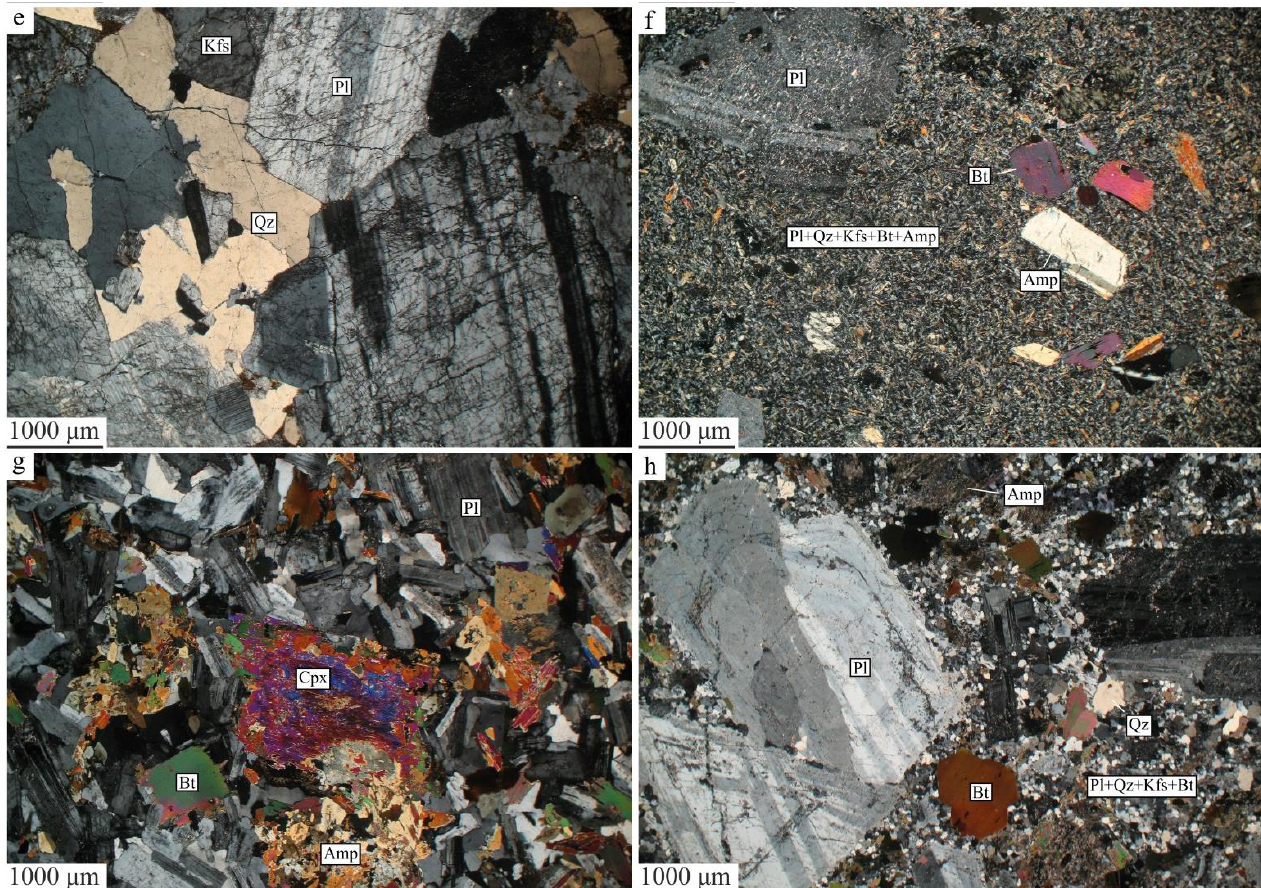
Figure 2. Representative photomicrographs showing in the petrographic characteristics of the Shakhtama Complex granitoids in the Lugokan, Kultuma and Bystrinsky deposits. Lugokan